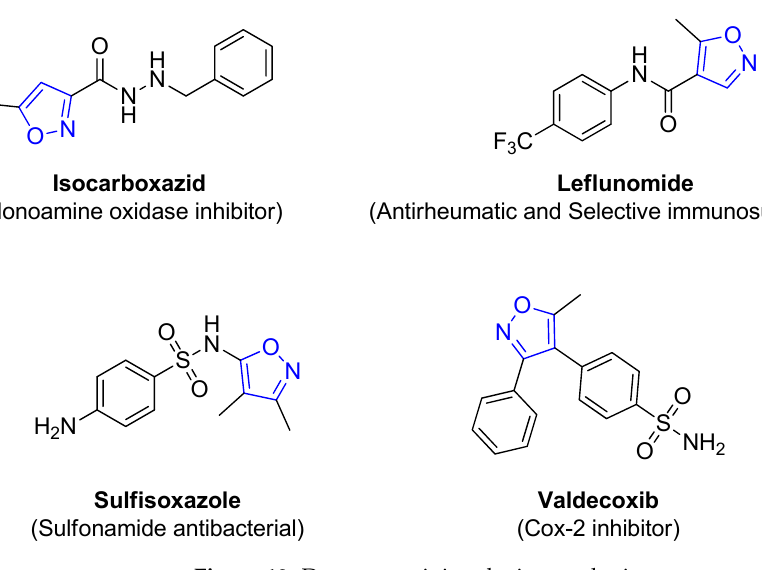
Figure 10. Drugs containing the isoxazole ring.